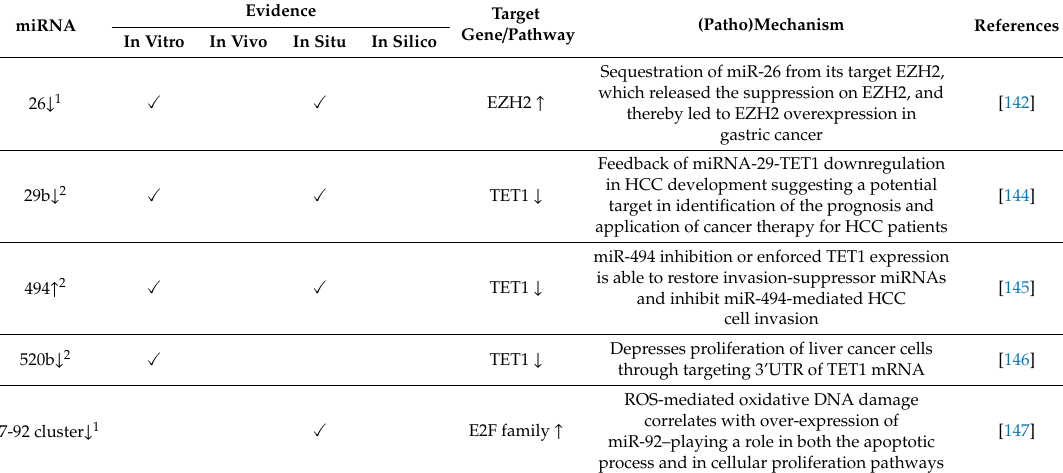
Table 5. Deregulated miRNAs and relation to OS in liver